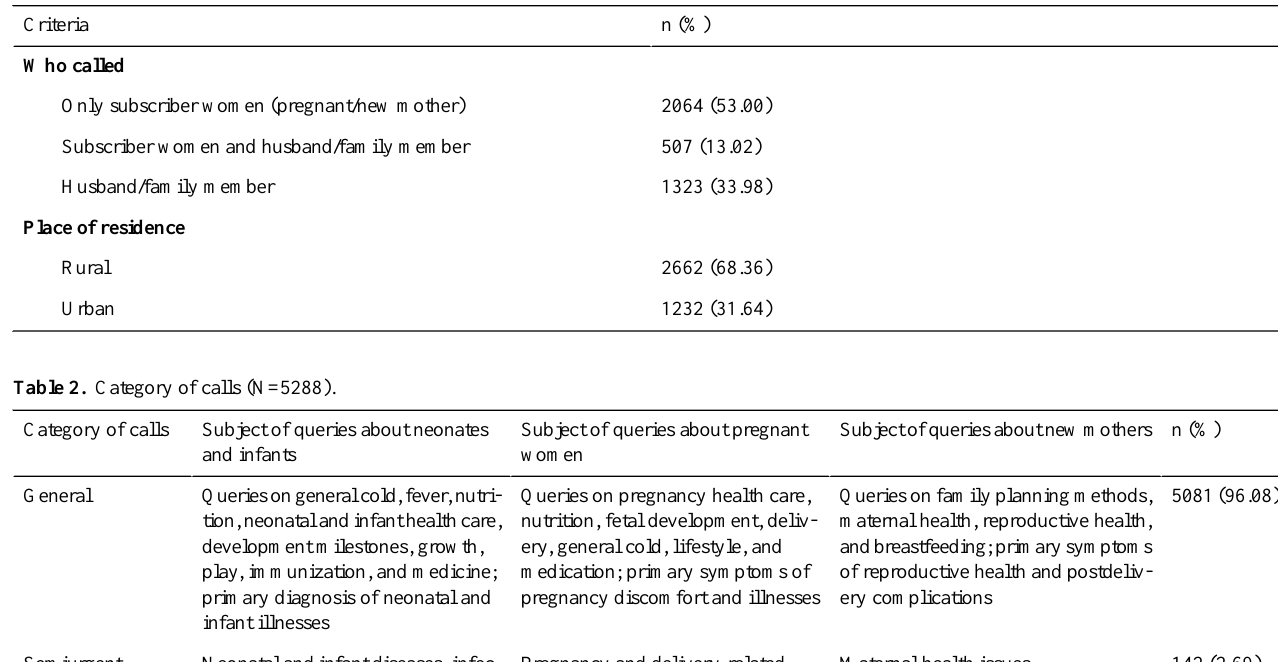
Table 1. Caller type and location (N=3894).